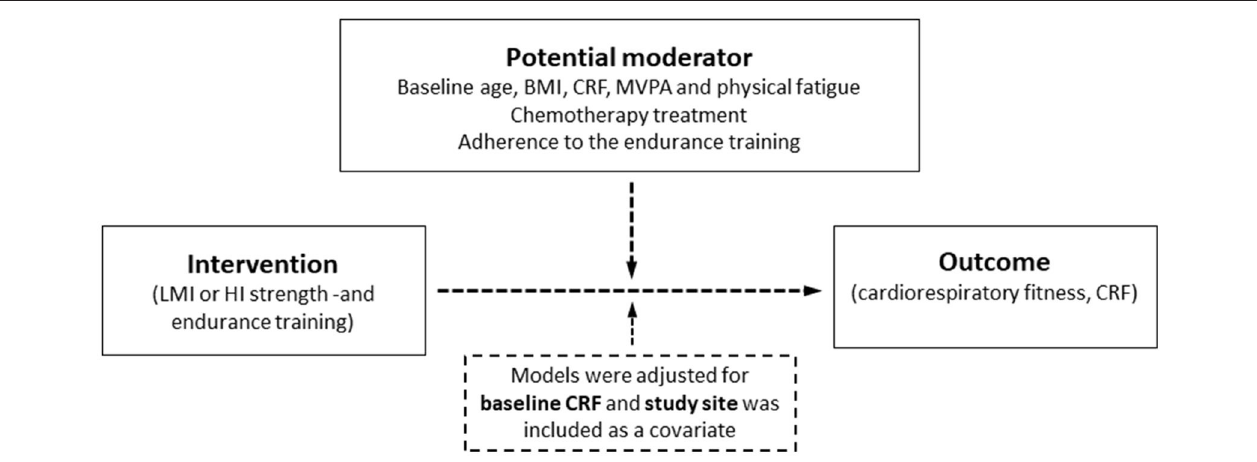
FIGURE 1 | The hypothesized moderation model. Intervention effect (mean difference in change between low-to-moderate intensity (LMI) and high intensity (HI) training) on peakimal oxygen uptake (VO 2 peak) post-intervention. The potential moderator variables investigated were baseline age, body mass index (BMI), cardiorespiratory fitness (CRF), hours in moderate-to-vigorous physical activity (MVPA), physical fatigue, chemotherapy treatment (yes/no), and adherence to the endurance training. Each of the potential moderator variables was included in the regression model one at a time, resulting in a total of seven models.